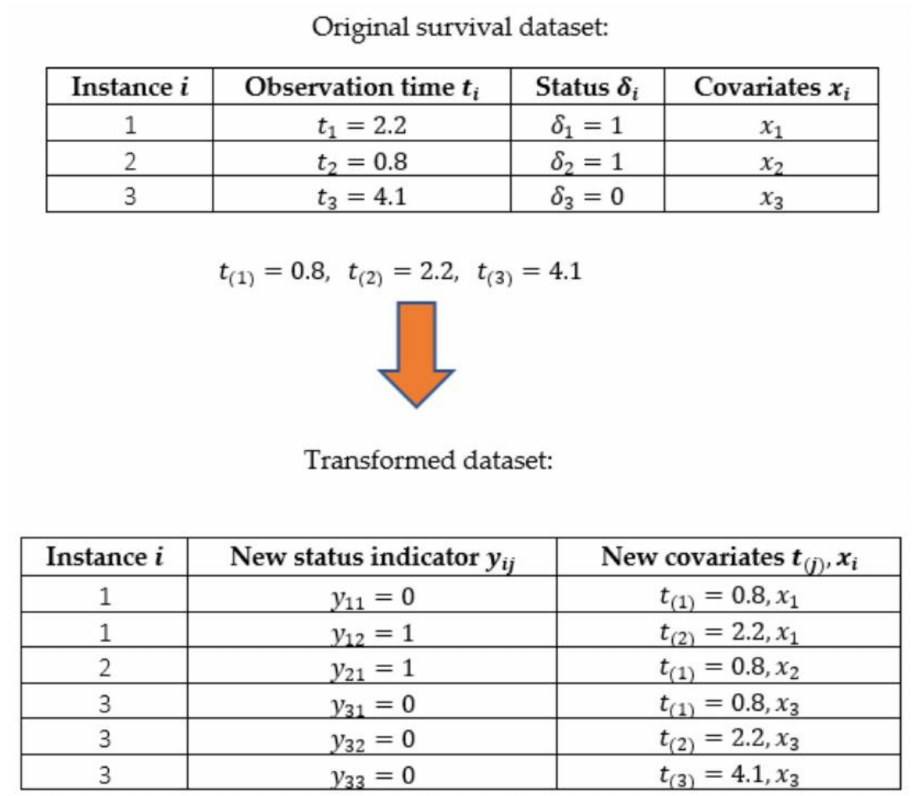
Figure 2. Transform the original survival dataset into a binary classification